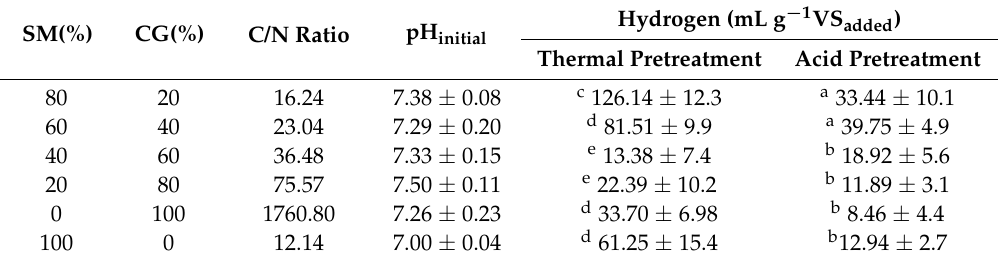
Table 2. Production of hydrogen with different concentrations of crude glycerol (CG) and swine manure (SM) with thermal- and acid-pretreated